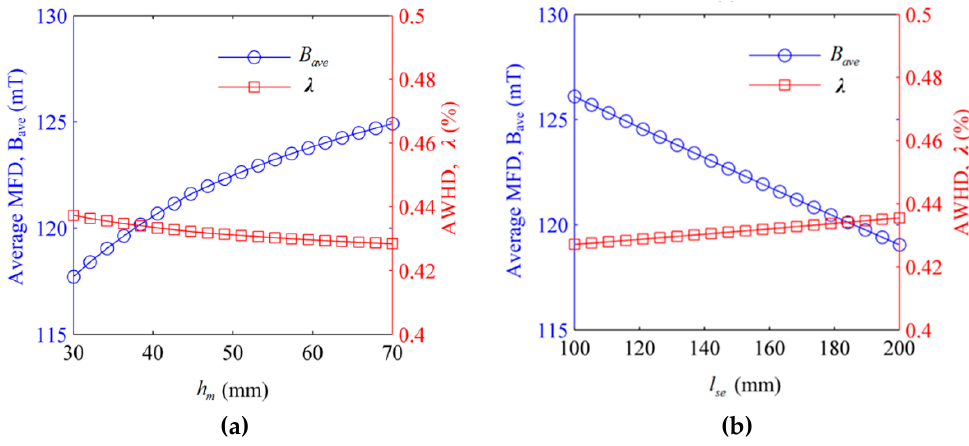
Figure 10. Average MFD and acceleration waveform harmonic distortion (AWHD) vs.: ( a ) h m ; ( b ) l se .